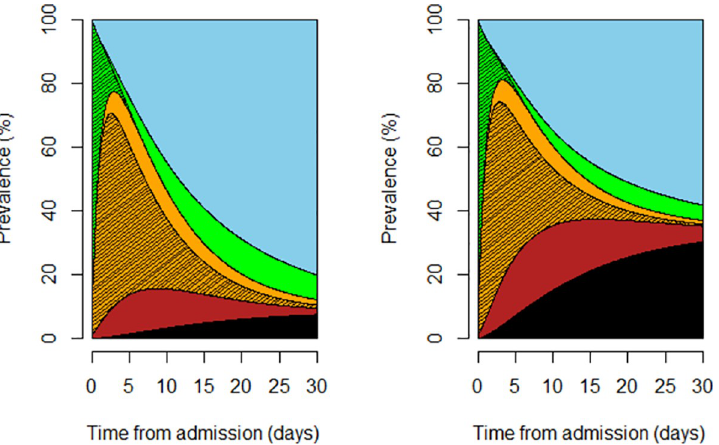
Fig 2. The predicted prevalence of patients in each respiratory support state was estimated in the stack probability plot, comparing patients who were treated with tocilizumab from the OT state onwards (left plot) and patients who were not treated with tocilizumab during hospitalization (right plot). Color code: black = death; blue = discharge; red = non-invasive ventilation/invasive mechanical ventilation; orange = oxygen therapy; green = no respiratory support. The strikethrough area refers to NRS or OT, whereas the “clean” areas refer to NRS or OT in